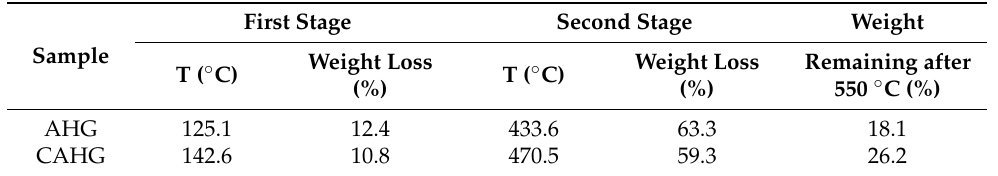
Table 1. Schedule of experiment instruments.